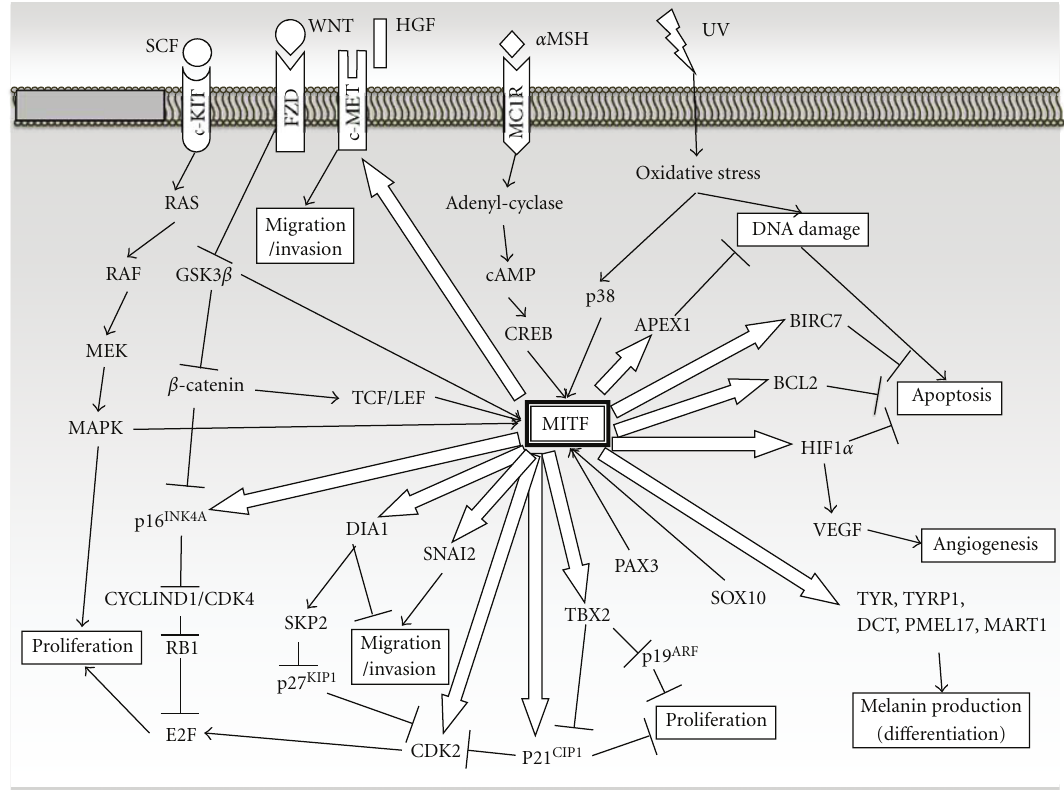
Figure 1: MITF-centered schematic scheme of cellular signaling on melanoma development and progression. Open arrows indicate direct transcriptional targets of MITF. The amount of transcripts of these targets is regulated by direct MITF binding to cis -elements in their promoter sequence. Black arrows or lines indicate signal cascades associated with melanoma development and progression. Arrows or lines toward MITF mean direct association by binding to the MITF promoter region or MITF protein. α MSH: melanocyte-stimulating hormone; BCL2: B-cell leukemia/lymphoma 2; BRN2: brain-2; CDK2/CDK4: cyclin-dependent kinase 2/4; CREB: cAMP-responsive